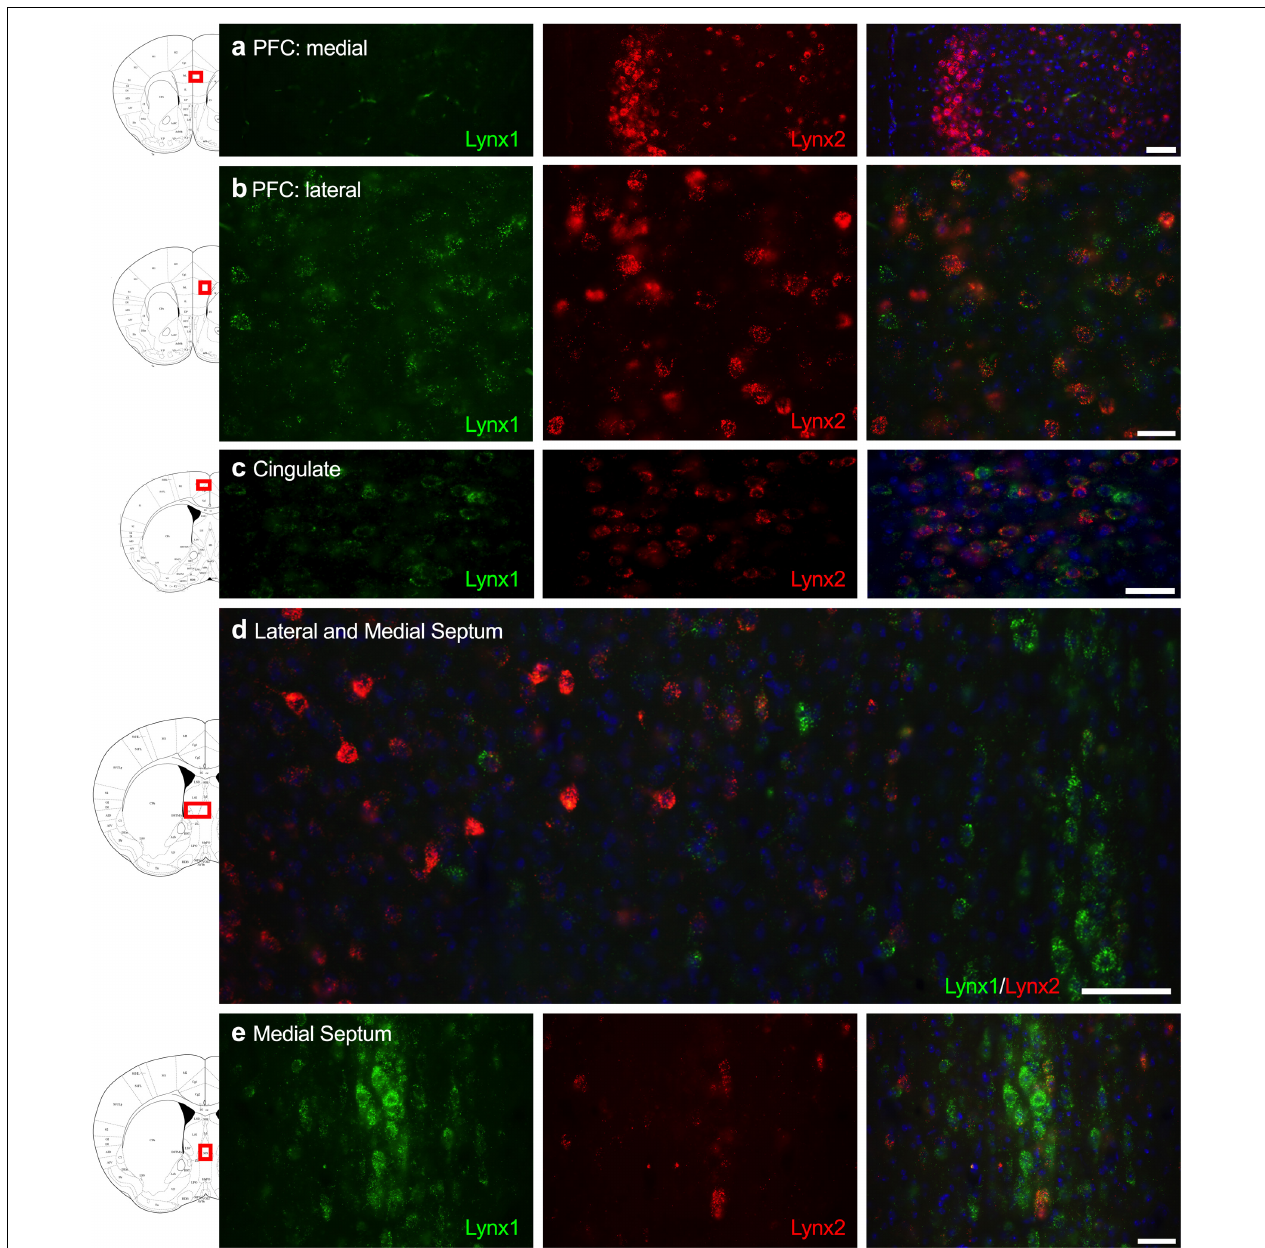
FIGURE 1 | Expression of lynx1 and lynx2 mRNA in the prefrontal cortex (PFC), cingulate cortex, and septum. (a) Lynx2 (red), but not lynx1 (green), is highly expressed in cells of the medial PFC. (b) In the lateral PFC, a different pattern emerged with cells expressing either lynx1 or lynx2, or both lynx1 and lynx2, in this region. (c) In the cingulate cortex, most cells expressed both lynx1 and lynx2, although cells were still identified that only expressed lynx1 or lynx2. (d) Lower magnification of the septum shows distinct region-specific differential expression of lynx1 and lynx2 in the medial and lateral regions, respectively. (e) Higher magnification of the medial septum shows a high density of lynx1-positive cells. The red boxes on the brain plates to the left of each row illustrate the region shown in the respective microscopy images. Blue: DAPI. Scale bar for ( a–c,e) 40 µ m. Scale bar for (d) 100 µ m.